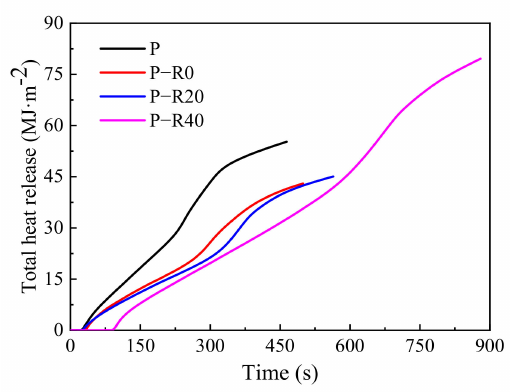
Figure 10. THR of control and modified wood